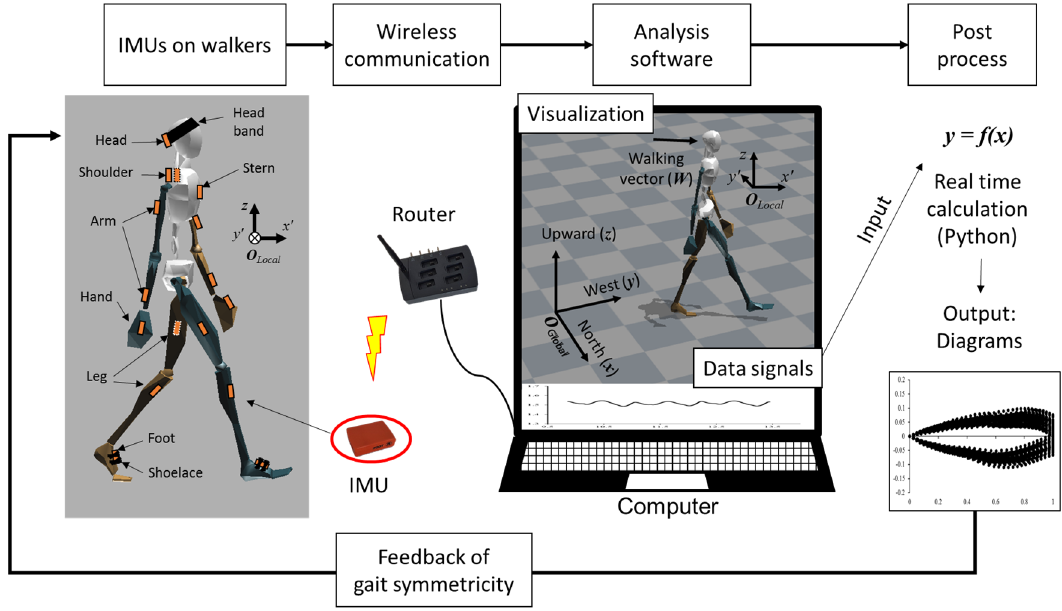
Figure 1. Overview of the proposed real-time feedback system, including the data accusation, the sensor placement, and the orientation of the coordinate systems.